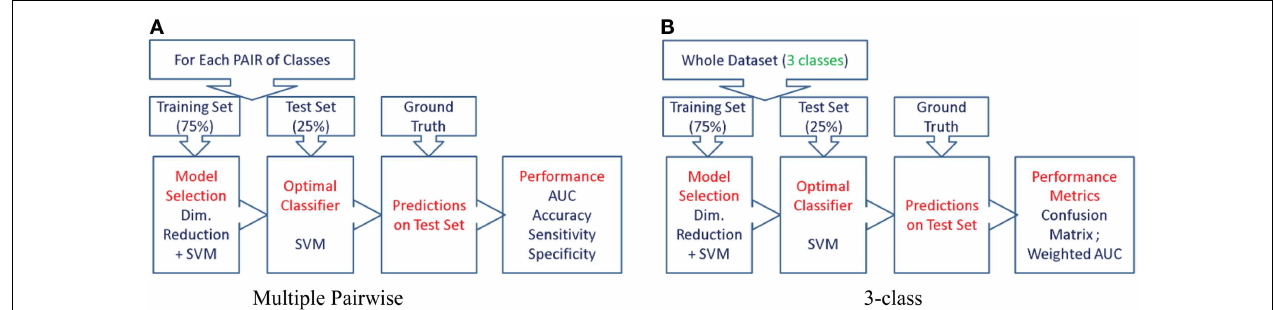
from the test set (25% of the cohort, or the subject left out in case of LOOCV).This way we can assess the predictive value of a given feature.This procedure is repeated for all the features from each structure and the predictive values are evaluated. For the three-class experiment, the results are presented in Figure 7 . Please note that for the multi-class experiment, we can only report accuracy and AUC.There are no metrics equivalent to sensitivity and specificity, but instead, generalized misclassification rates, as presented in Figure 8 . For the multiple-pair-wise experiment, the procedure is repeated for each pair NC vs. AD, NC vs. FTD, and AD vs. FTD (and for all the features) and the results are presented in Figure 8 . (A) Multiple-pair-wise, (B) three-class.